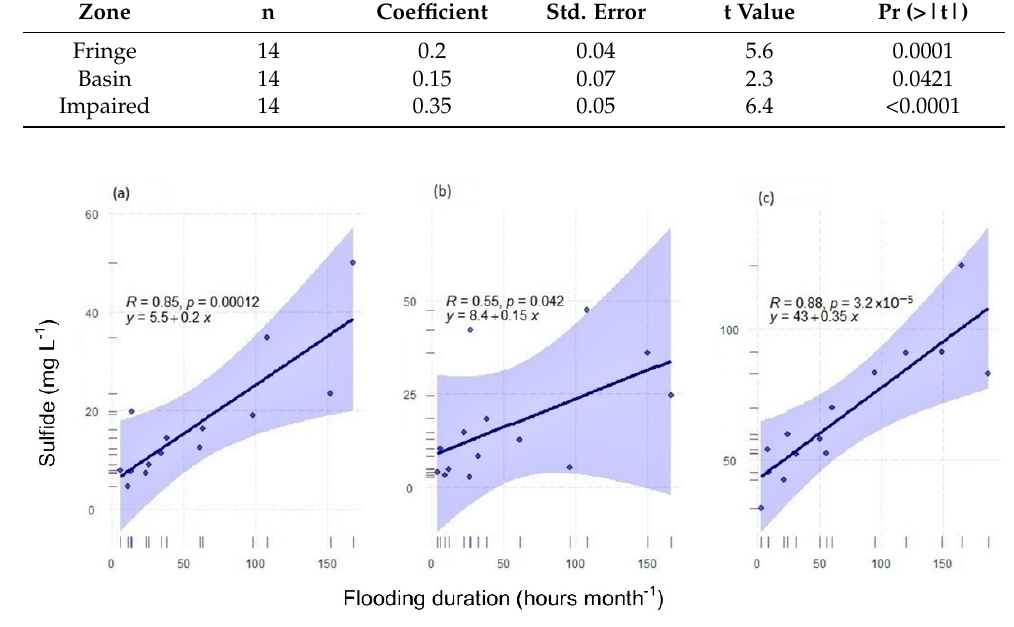
Figure 6. The linear relationship between the sulfide concentration and the flooding period in each mangrove study site. ( a ) Fringe mangrove, ( b ) basin mangrove, and ( c ) impaired